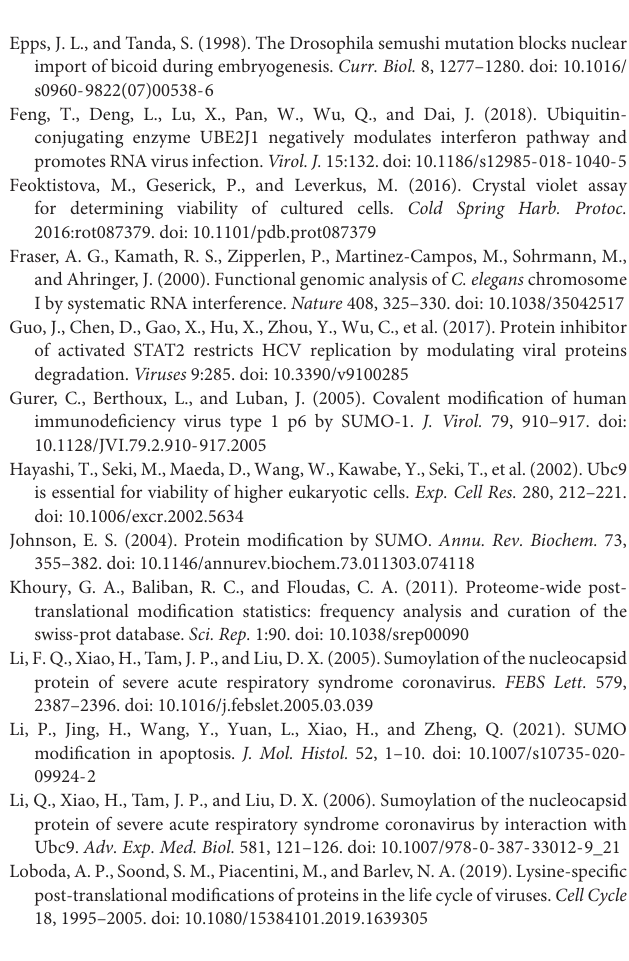
Supplementary Figure 1 | Cytotoxic effect of Ubc9 inhibitor (2-D08) in A. aegypti CCL-125 cells. A. aegypti CCL-125 cells were incubated with culture medium containing Ubc9 inhibitor (2-D08) as indicated for 2 days. Attached cells were measured by cell viability